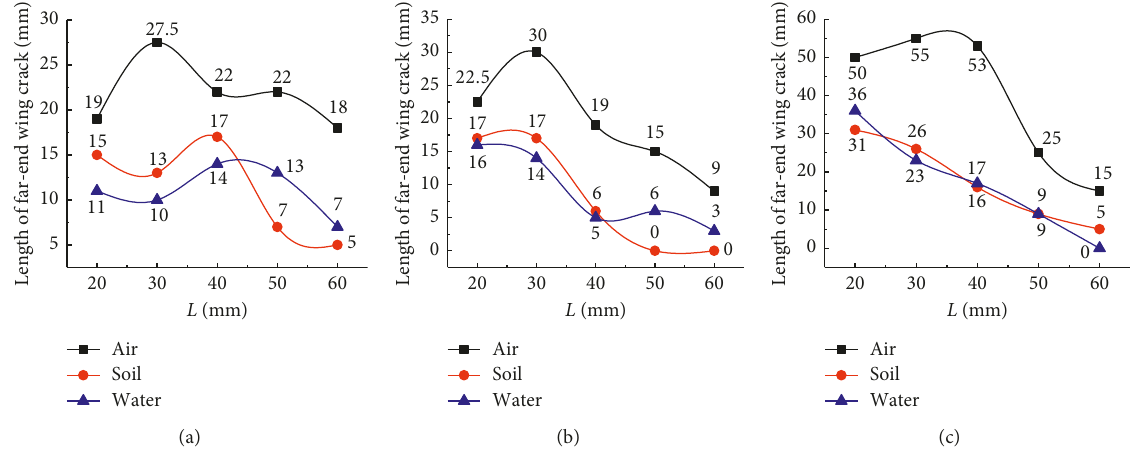
Figure 7: Relationship between fillings and far-end wing crack. (a) θ � 0 ° ; (b) θ � 45 ° ; (c) θ � 90 °